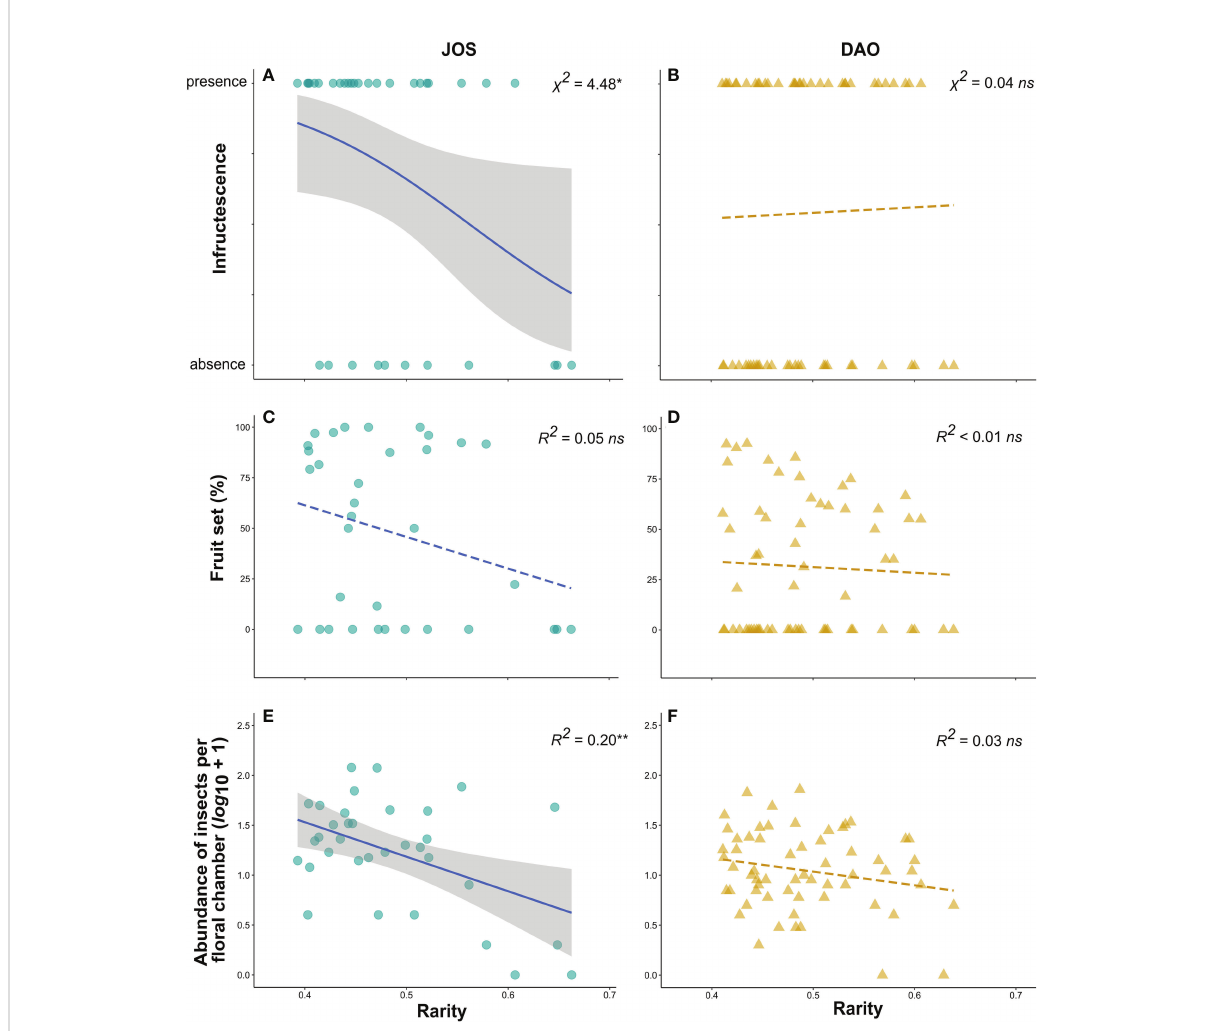
FIGURE 5 Rarity as predictor (A, B) of the presence/absence of an infructescence, using logistic regressions, (C, D) of fruit set (%), using linear regressions, and (E, F) of abundance of insects per fl oral chamber ( log 10 +1), using linear regressions, in the two studied populations of Arum maculatum from northern-central Austria (JOS; Salzburg; N = 34; A, C, E ) and northern Italy (DAO; Daone, Trentino; N = 61; B, D, F ). Solid lines indicate signi fi cant (* 0.01 < P ≤ 0.05; ** 0.001 < P ≤ 0.01) model fi tting and shaded areas represent 95% con fi dence intervals. ns , non-signi fi cant ( P >